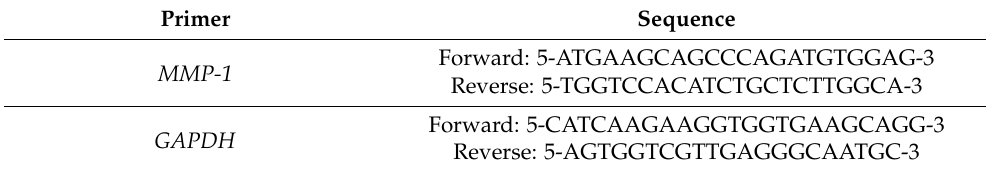
Table 1. Specific primers for MMP-1 and GAPDH